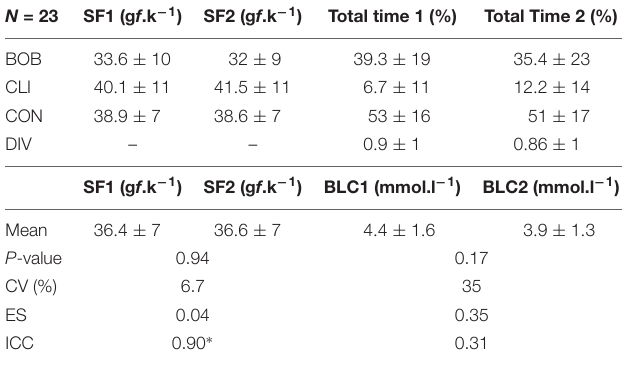
TABLE 4 | Mean values of swimming force (SF), percentage of time spent in each swimming pattern (total time) for bobbing (BOB), climbing (CLI), continuous (CON), diving (DIV), and blood lactate concentration (BLC) followed by the P -value of test t ( P -value), coefficients of variation (CV), effect size (ES), and intraclass correlation (ICC) between test (SF1 and BLC1) and retest (SF2 and BLC2), of 23 rats. N =